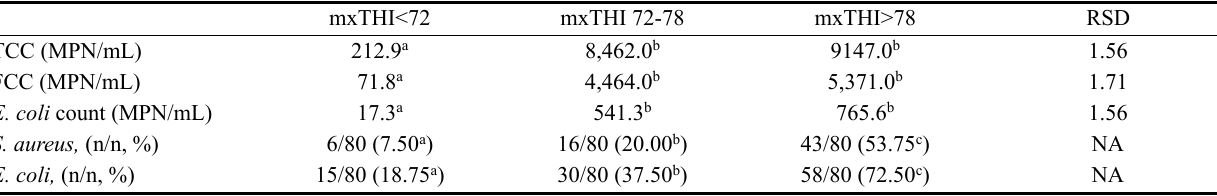
RSD, residual standard deviation; TCC, total coliform count; FCC, fecal coliform count; MPN, most probable number; E. coli , Escherichia coli ; S. aureus , Staphilococcus aureus ; NA, not applicable; n/n = number of positive samples for S. aureus and E. coli on total samples examined. a,b,c p<0.001.